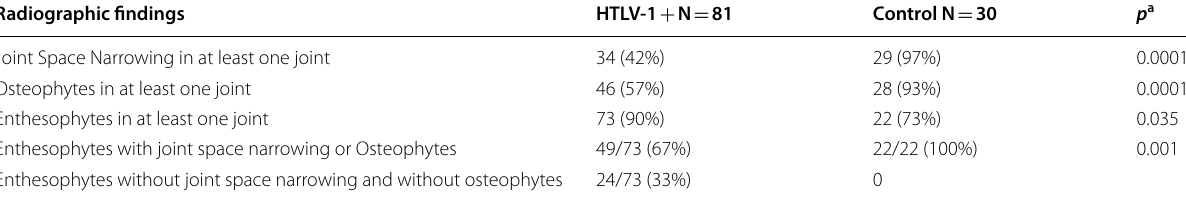
Table 2 Frequencies of main radiographic findings in 81 HTLV-1-infected patients and 30 controls with osteoarthritis